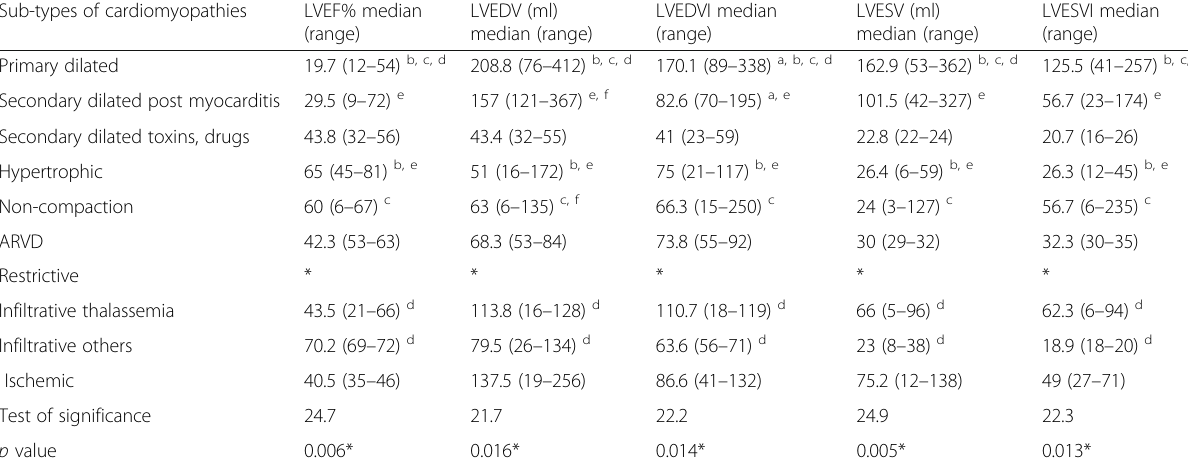
Table 2 Left ventricle parameters of CMR in studied children of different sub-types of cardiomyopathy Sub-types of cardiomyopathies